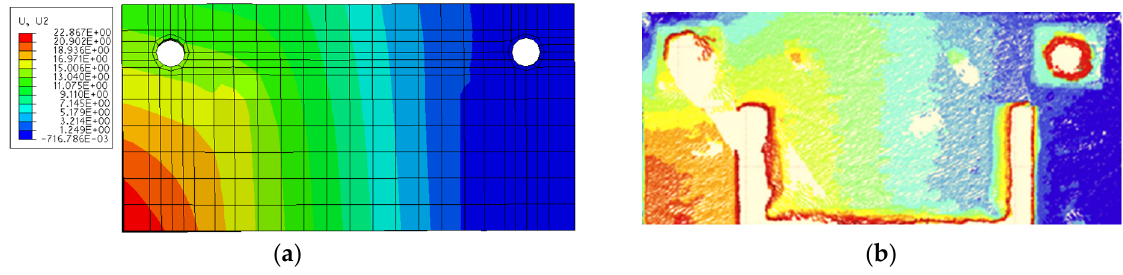
Figure 5. Modes of failure of the base plate: ( a ) FE model and ( b ) experimental test.